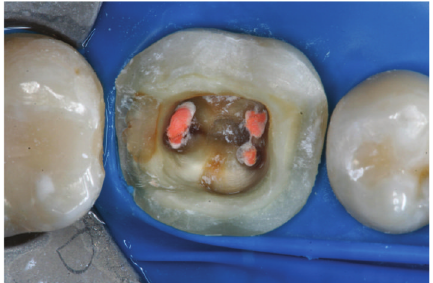
Figure 4: The tooth is first prepared by making the coronal pulp chamber continuous with the access cavity. The remaining tooth structure is still